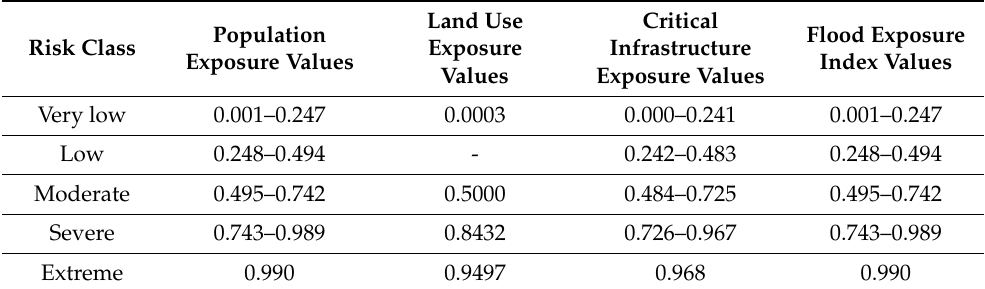
Table 2. Risk classes assigned to fuzzy values for flood exposure indicator maps and the overall flood exposure index